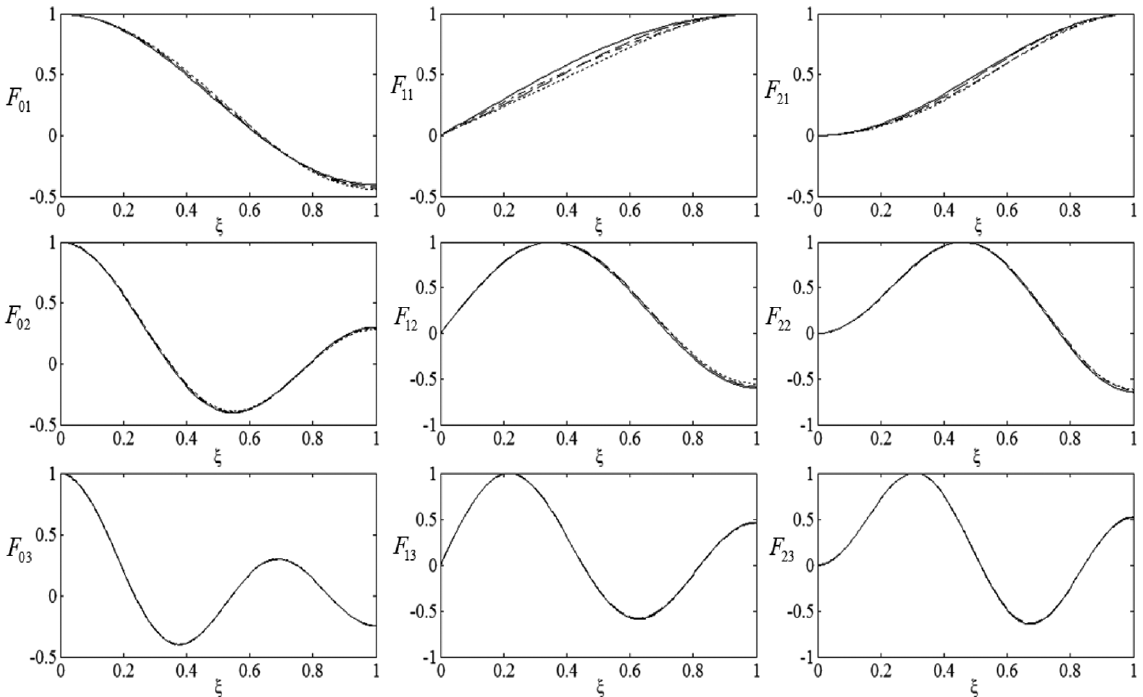
Fig. 6. Radial surface pro fi les F ml ( m = 0,1,2, l = 1, 2, 3) of the natural modes for parameters: β = 1, β 1 = 0.3 and four different α ( α = 0.2, α = 0.4, α = 0.6, α =